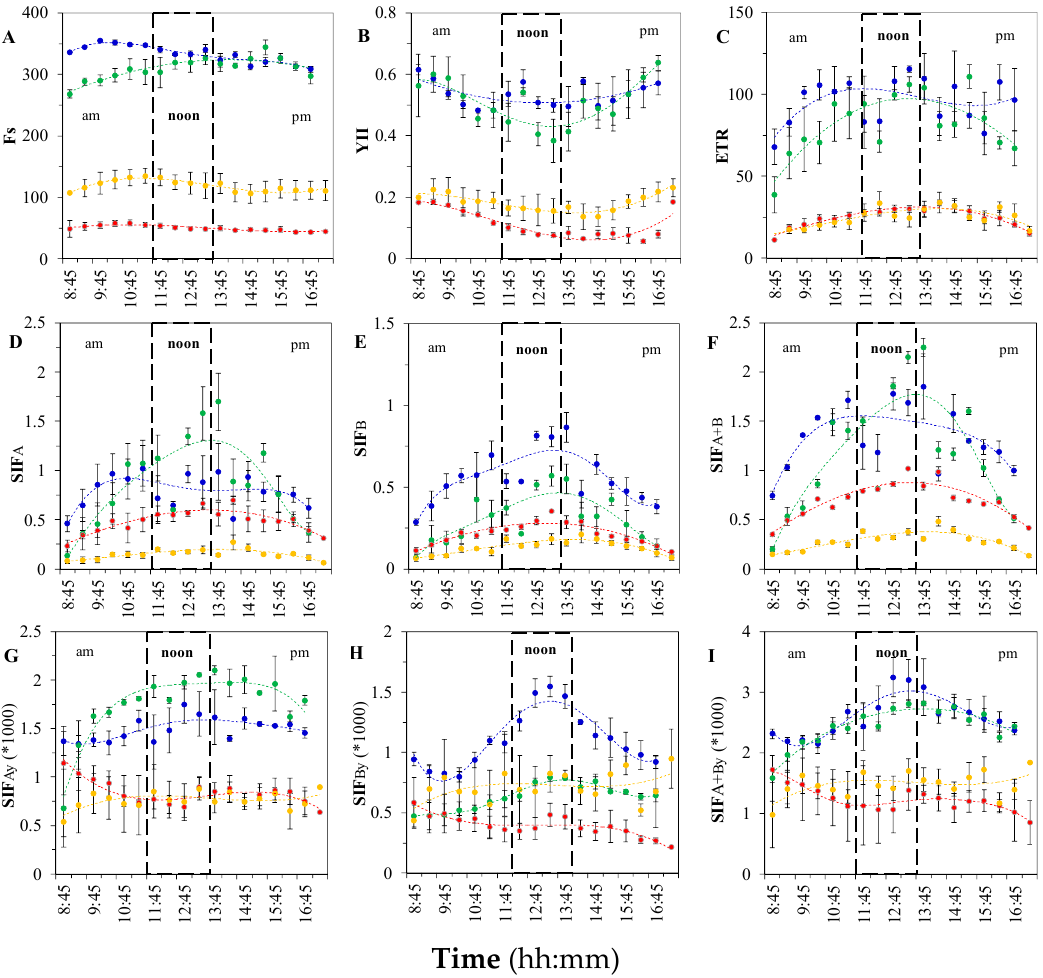
Figure 5. Diurnal and seasonal variations in leaf-level light-adapted PAM fluorescence metrics (Fs, YII and ETR, A – C ); canopy solar induced fluorescence (SIF, D , E ), and SIF yields (SIFy, G – I ). The growth stages are indicated in different colors (blue—young, green—mature, red—early senescence, yellow—late senescence). Each value represents a mean (±SE of the mean) of the measurements collected at this time on three consecutive clear days representing each growth sage.